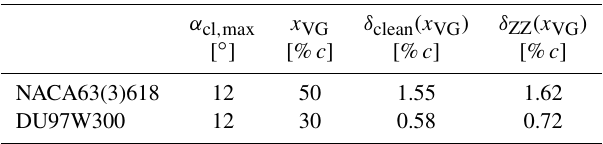
Figure 5. (a) Height and location of passive flow control devices. (b) Particle image velocimetry (PIV) measurements of VG vor- tices on the NACA63(3)618 in spanwise view ( h VG = 1 . 7% c at x PIV = 80% c and Re = 1 . 3 × 10 6 ) (reproduced from Mueller-Vahl et al., 2012). (c) CFD simulations of a MGF on the HQ17 in side view ( h GF = 0 . 5% c at α = 4 ◦ and Re = 1 × 10 6 ) (reproduced from Schatz et al., 2004a). Table 5. XFOIL simulations of the boundary layer thickness ac- cording to Eq.